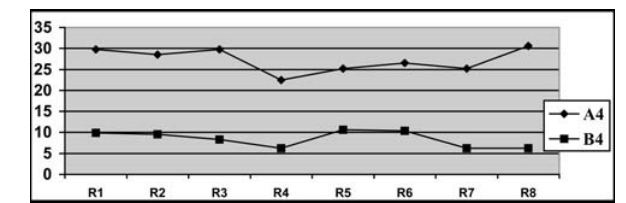
FIGURE 1 - Concentration of neutral sugars for A4 and B4 subgroups (mg/ml)